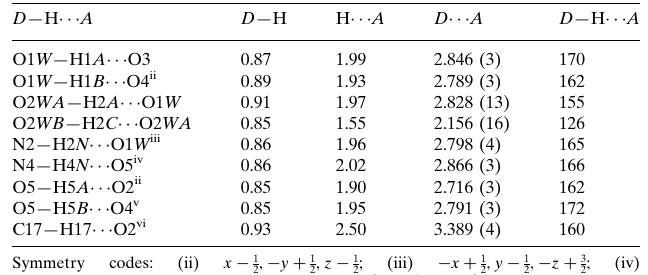
Related literature